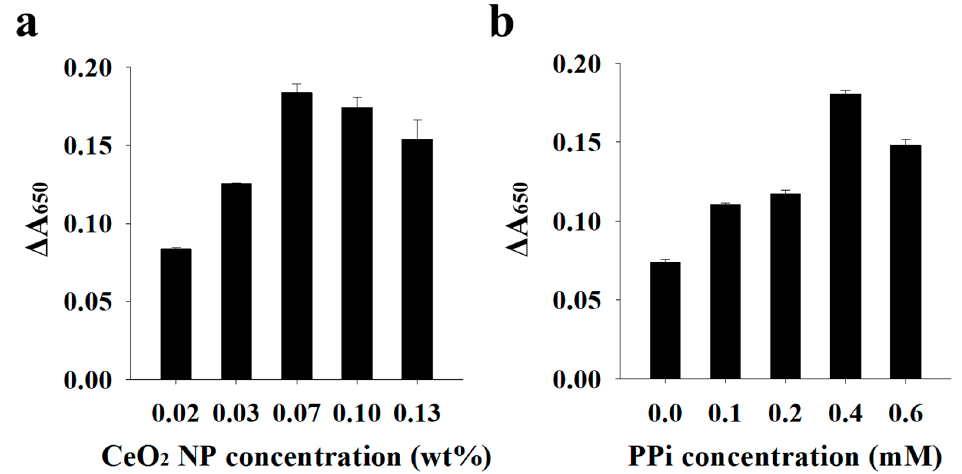
Figure 4. Optimization of the proposed colorimetric system. ( a ) CeO 2 NP concentration. ( b ) PPi concentration. Change in absorbance signal ( ∆ A 650 ) was calculated by subtracting A 650 in the presence of DNA from that in the absence of DNA.